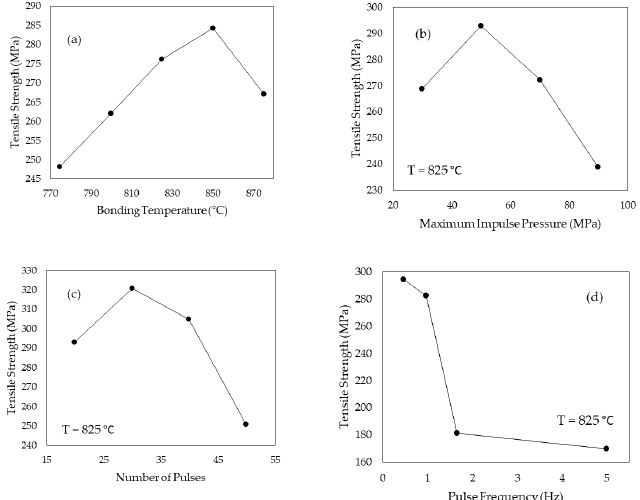
Figure 3. Optimization of IPADB parameters: ( a ) bonding temperature, ( b ) maximum impulse pressure, ( c ) number of pulses and ( d ) pulse frequency for bonding of Ti (TA17) and 304 stainless steel after Yuan et al. [26].